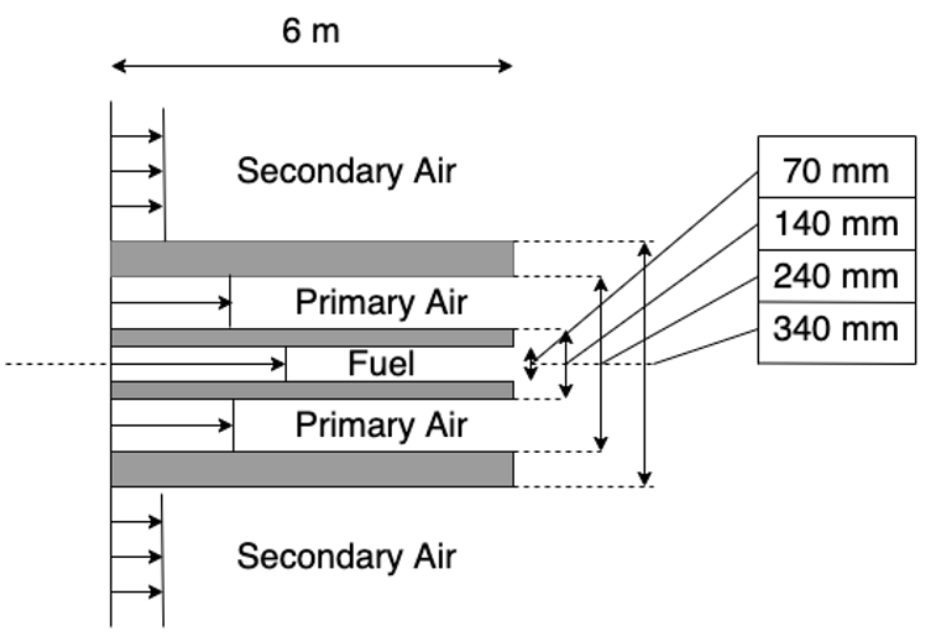
Figure 3. Burner